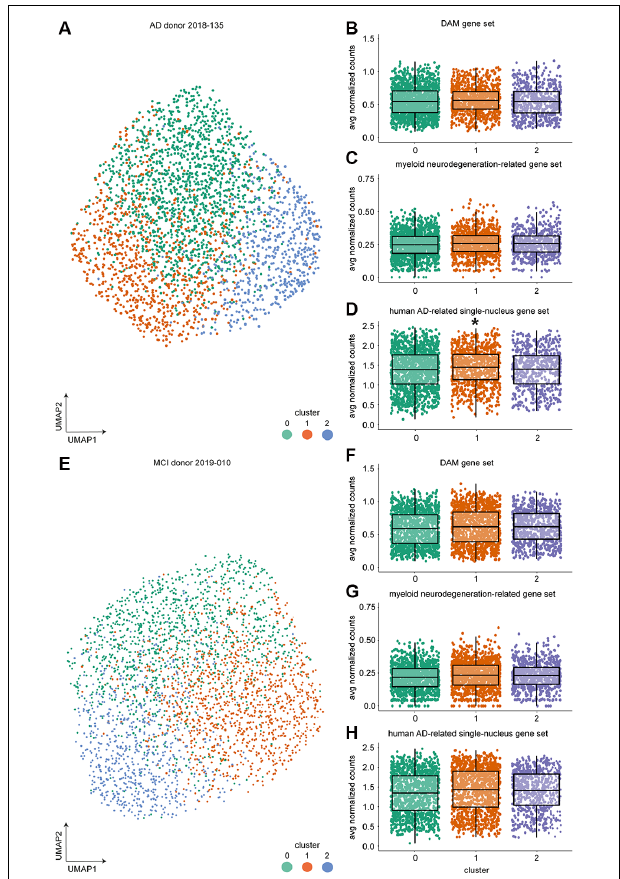
FIGURE 4 | Single-cell expression profiling of microglia from individual donors identified three clusters but no DAM-like cluster using 10 × Genomics. (A) UMAP visualization and unsupervised clustering of microglia from AD donor 2018-135. (B–D) Average expression of the mouse DAM (B) , myeloid neurodegeneration-related (C) , and human AD-related single-nucleus (D) gene set expression per cell across clusters for AD donor 2018-135 (multiple linear regression with Bonferroni correction, *indicate p -value < 0.001). (E) UMAP visualization and unsupervised clustering of MCI donor 2019-010. (F–H) Average expression of the mouse DAM (F) , myeloid neurodegeneration-related (G) and human AD-related single-nucleus (H) gene set expression per cell across clusters for MCI donor 2019-010. Horizontal lines in the boxplots represent the mean; the lower and upper hinges represent the 25th and 75th percentiles. Abbreviations: AD, Alzheimer’s Disease; avg, average; CPM, counts per million; CTR, Control; CTR+, Control with A β plaques and/or hyperphosphorylated tau; DAM, disease-associated microglia; MCI, mild cognitive impairment; UMAP, uniform manifold approximation and